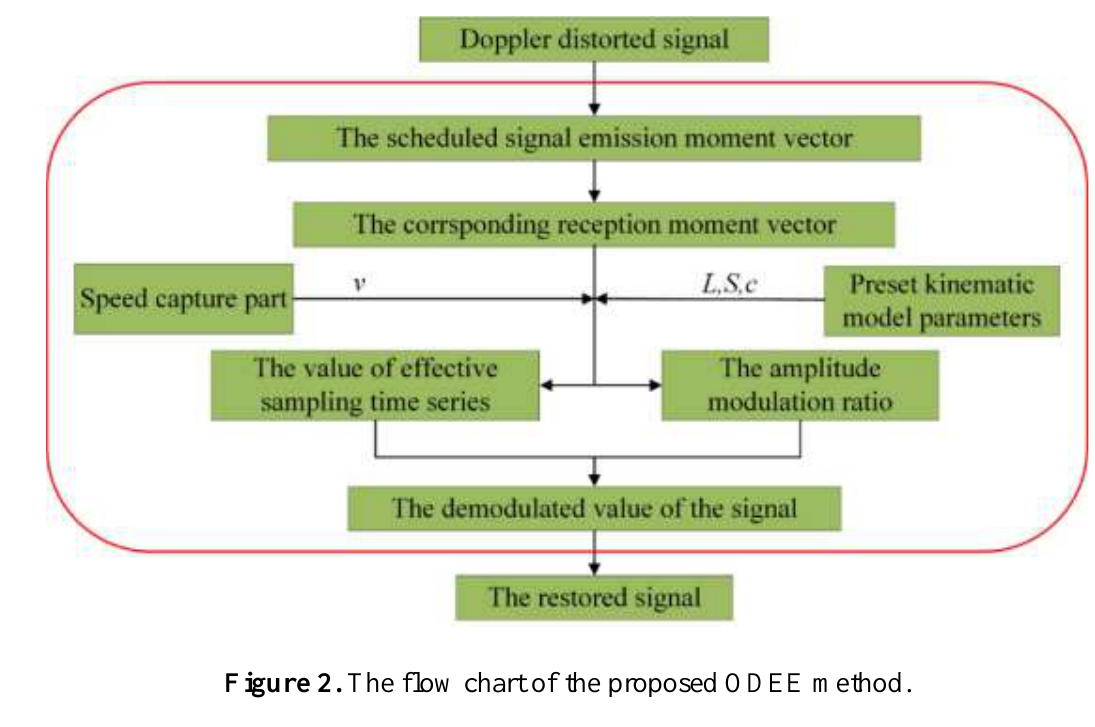
Figure 2. The flow chart of the proposed ODEE method.